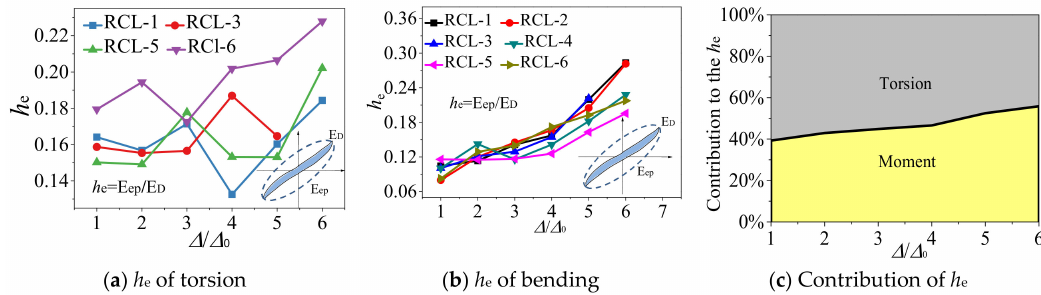
Figure 10. Equivalent damping ratio